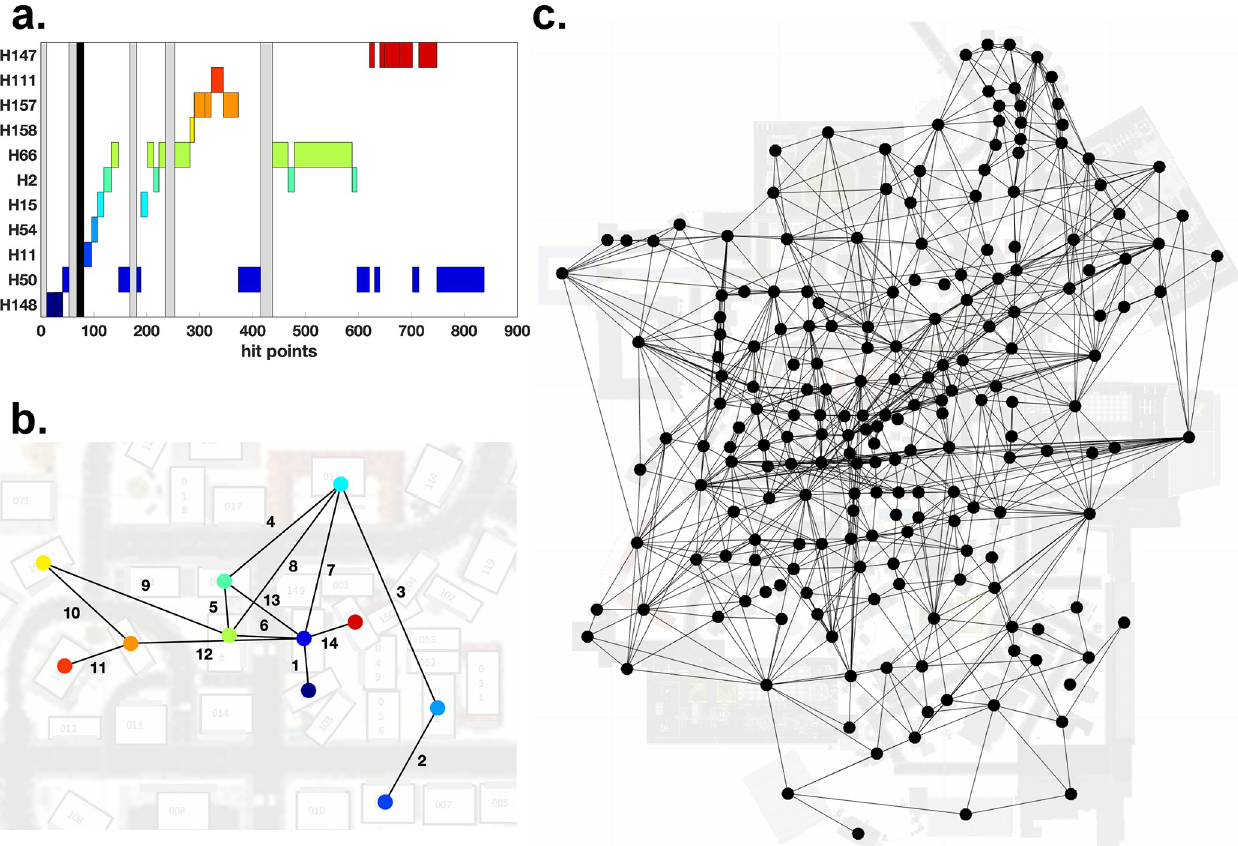
Fig 3. Graph creation. (a) Timeline of gaze events by a participant. The abscissa represents the first 30 seconds (900 hit points) of the recordings. The ordinate contains all viewed houses viewed during that time line. We number houses and name them accordingly, e.g., H148 for house number 148. In this panel each house has a distinct color for visualization only. The grey bars represent clusters of the NH category, which are not considered during graph creation. The black bar identifies a remaining cluster of missing data samples. Therefore, no edge will be created at this moment in the timeline. (b) The graph corresponding to the timeline of panel A is visualized on top of the map of Seahaven. The colors of the nodes match the colors of the boxes in panel A. Edges are labelled according to the order they were created. (c) The complete graph of a single participant based on all gaze events during 90 min of exploration visualized on top of the 2D map of Seahaven. Note that in this visualization the locations of the nodes correspond to the locations of the respective houses they represent in Seahaven, however, this locational information is not contained in the graph